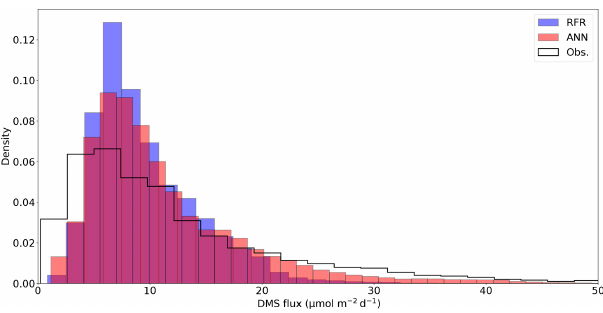
Figure 5. Histograms of DMS sea–air flux distributions derived from the 1000-model ensemble random forest regression (RFR) and artificial neural network (ANN) predictions, as well as cruise observations (Obs.). The sample sizes of both models are equiv- alent ( n = 49632) and are significantly higher than the observa- tional dataset ( n = 2063). Note that the distribution is restricted to show trends, with a maximum flux of 238nM (Obs.). The upper tail ( > 50nM) consists of only 2.9% (Obs.) and < 0 . 1% (both RFR and ANN) of the values. Note that the ANN better predicts the upper tail of DMS observations greater than 20nM.